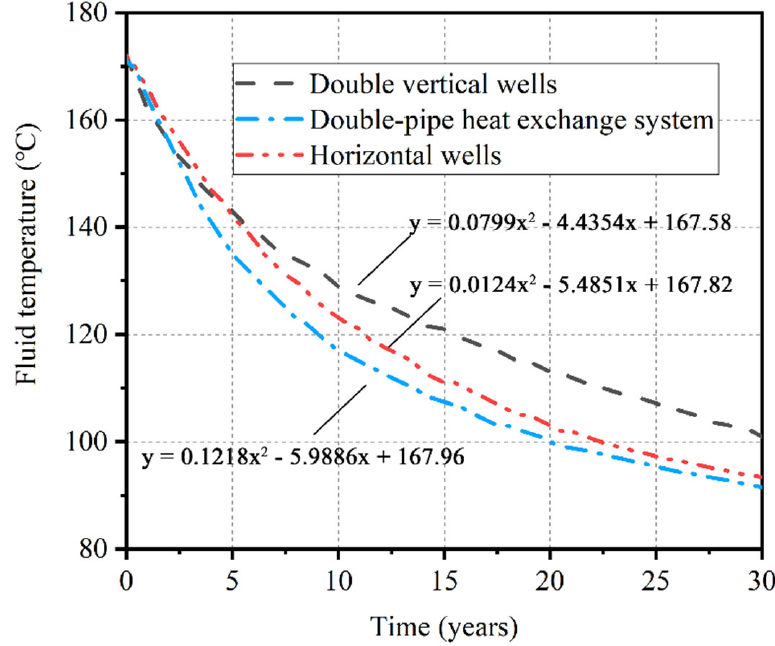
Figure 12. Average production temperature curve.